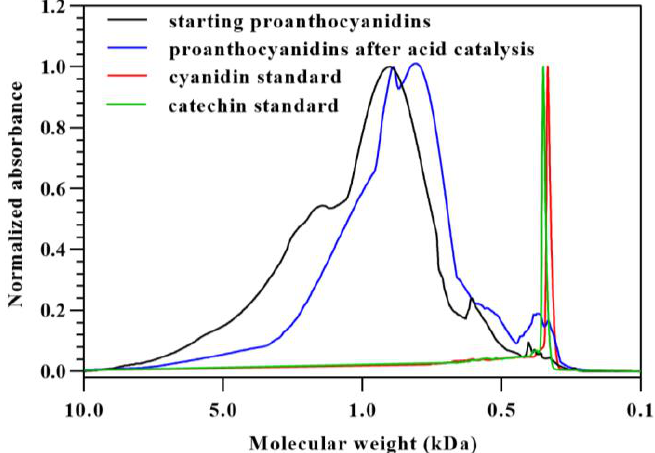
Figure 3. Molecular weight distributions of starting proanthocyanidins, proanthocyanidins after acid-catalyzed cleavage in the absence of phloroglucinol, cyanidin, and catechin.